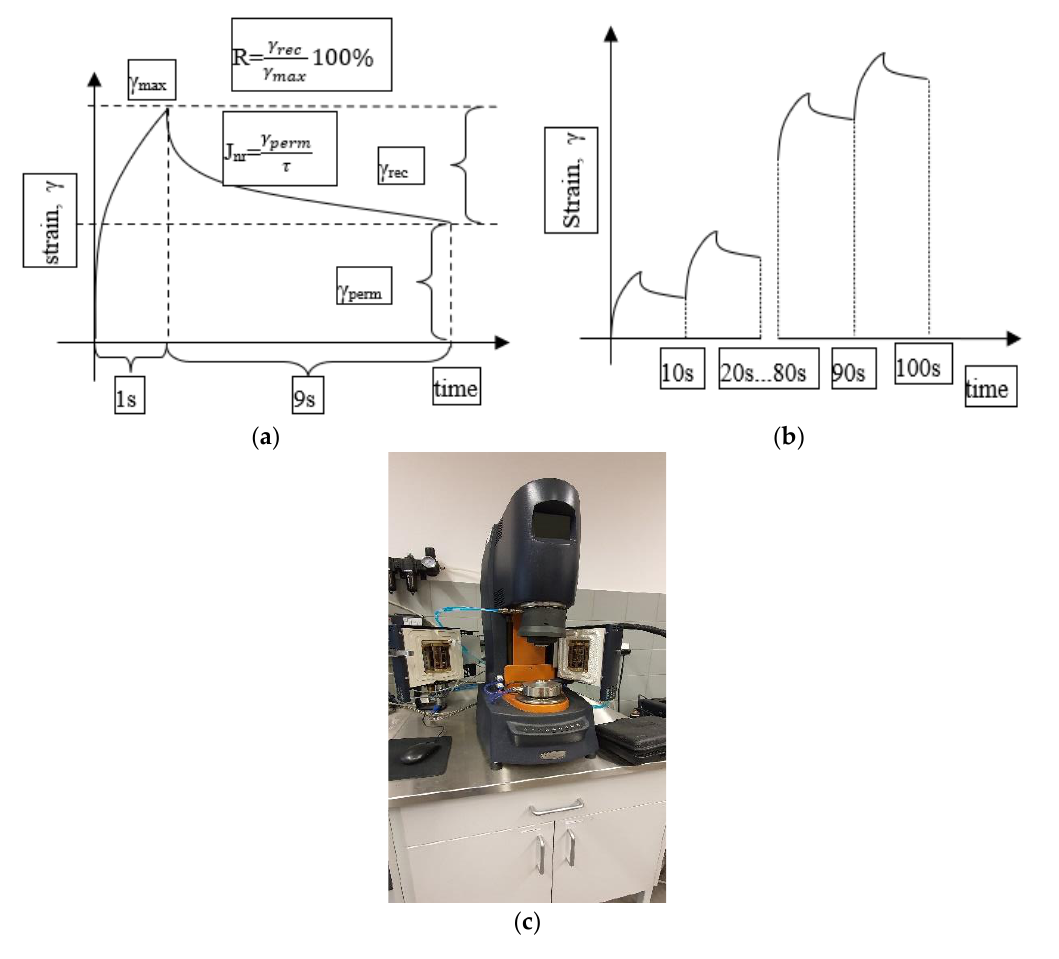
Figure 3. Execution principle of MSCR test; ( a ) one cycle scheme; ( b ) scheme of full test for 10 cycles; ( c ) Discovery Hybrid Rheometer HR-1 setup.